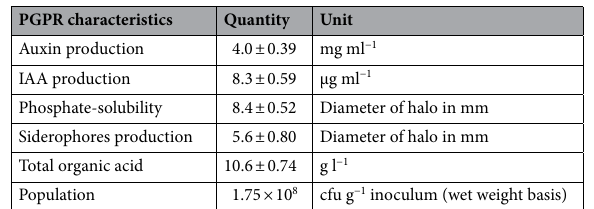
Table 2. Auxine, indole acetic acid (IAA), organic acid and siderophore production, phosphate-solubilization and population by/of PSB. ± Values represent SE of mean (n = 3).